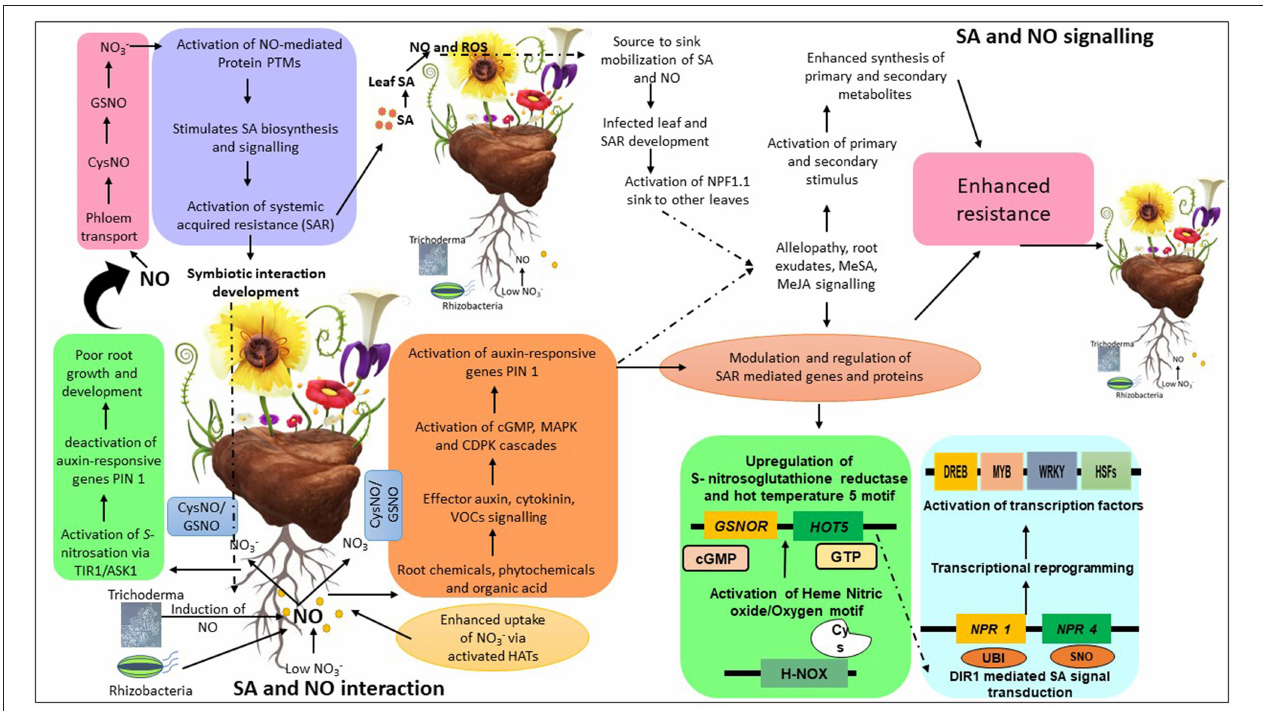
FIGURE 3 | A model depicting interactive mechanisms of salicylic acid (SA)/nitric oxide (NO) and microbes and their repercussions on plant growth and immunity. Both plants and rhizomicrobes stimulate the biosynthesis of various signaling molecules such as SA and NO to establish a mutual relationship. The NO level in root is induced in the presence of beneficial microbes which is then rapidly transported to different part of the plant by activation of histone acetyl transferase (HATs) which in turn activate various signaling cascades involved in the regulation of root growth and development. Whereas, NO mediated post translation modification (NO-PTMs) such as S-nitrosation deactivates the root auxin biosynthesis gene PIN1 resulting in poor root growth. Once NO moves to leaf area via phloem, it interacts and activates SA biosynthesis and signaling. NO-mediated activation of SA leads to the development of systemic acquired resistance (SAR) which results in the stimulation of secondary metabolite synthesis and transcriptional reprogramming of various stress responsive genes/proteins via activation of non-expresser of pathogenesis related protein 1 (NPR1) resulting in enhanced growth and immunity. CysNO, Cysteine nitric oxide; GSNO, S -Nitrosoglutathione; TIR1, Transport inhibitor response 1; ASK1, Kinase associated protein 1; PIN1, Pinnoid1; PTMs, Post-translational modifications; ROS, Reactive oxygen species; MAPK, Mitogen activated protein kinase; CDPK, Calcium dependent protein kinase; VOCs, Volatile organic compounds; H-NOX, Heme nitric oxide; NPF1.1, Nitrate transporter 1/peptide transporter family protein; UBI, Ubiquitination; SNO, S-nitrosation; DREB, Dehydration responsive element binding protein; MYB, Myeloblastosis; HSFs, Heat shock